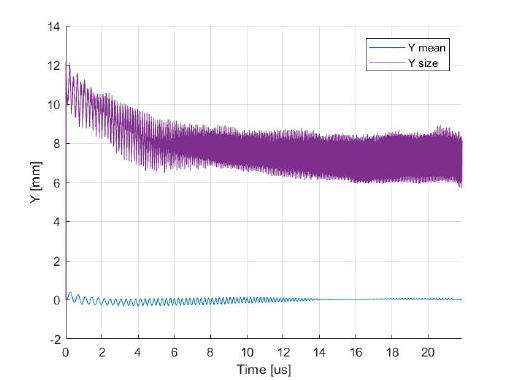
Figure 18. Beam transverse envelope of non-symmetric sliding shorts.